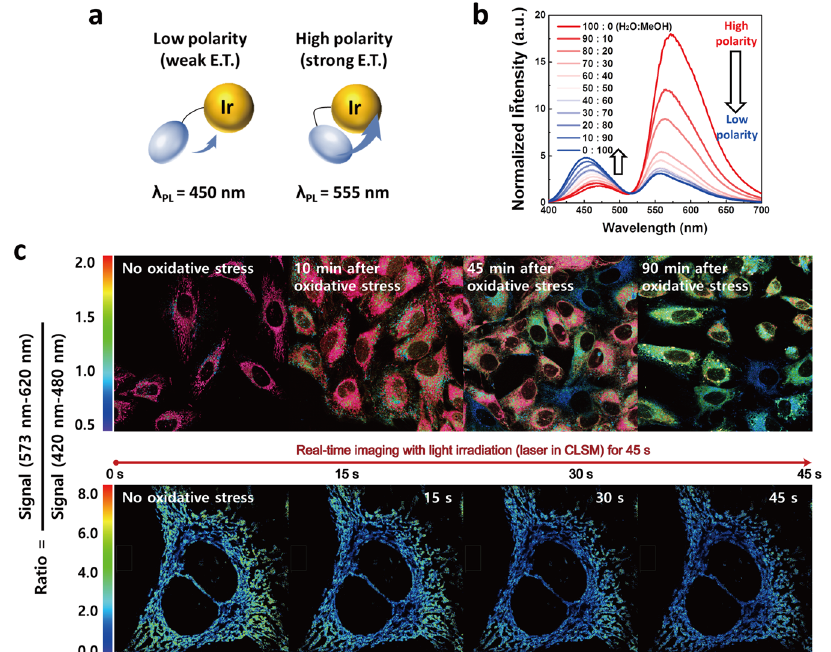
Fig. 5 Mitochondrial depolarisation by photoactivation of Ir-OA. a Schematic illustrating polarity dependent energy transfer ef fi ciency changes and ( b ) following ratiometric emission property changes depending on the H 2 O:MeOH ratio. c Ratiometric CLSM imaging of HeLa cells with Ir-OA according to giving oxidative stress. Ratiometric emission was observed 0, 10, 45, and 90 min after oxidative stress exposure (LED array, λ = 400 nm; light dose = 0.17 J cm − 2 ) (top, scale bars = 50 μ m), and the mitochondrial polarity change was monitored by the real-time ratiometric imaging during photoactivation within 60 s (bottom, scale bars = 20 μ m). The CLSM instrument ’ s laser excited Ir-OA for real-time imaging (bottom). Ratio = (emission of acceptor, λ em = 573 – 620 nm/emission of donor, λ em = 420 – 480 nm). Normal mitochondria with high MMP: red (top) and green (bottom). All imaging was repeated three times independently, and each experiment showed similar results. Source data are provided as a Source Data fi